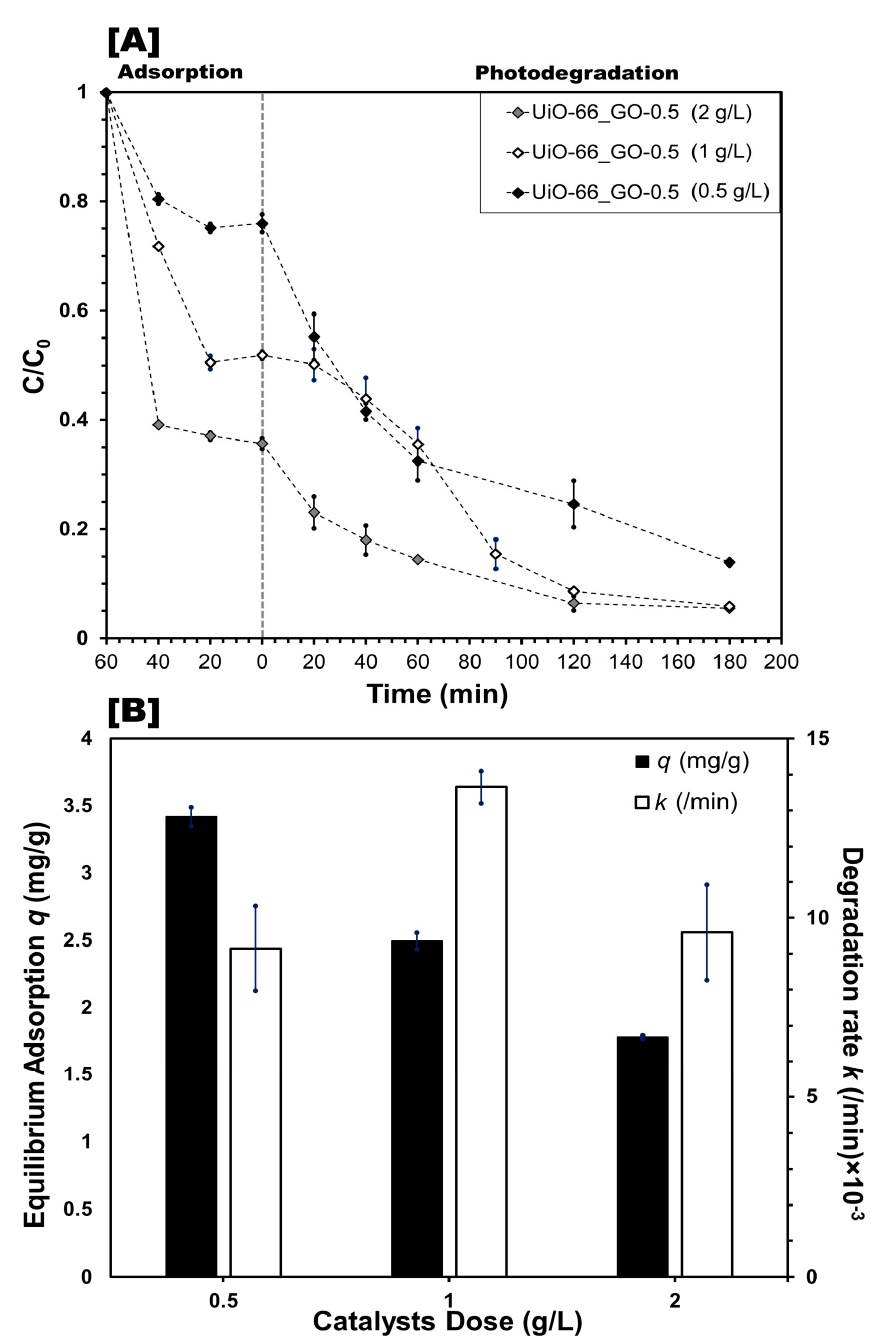
Figure 4. ( A ) Adsorption and photodegradation and ( B ) equilibrium adsorption and photocatalytic rate k of different photocatalyst doses (experimental conditions: initial CBZ concentration = 5 mg/L; pH = 7±0.2; concentration of UiO-66_G-0.5 = 0.5, 1, or 2 g/L; solution volume V = 50 mL). Plots and error bars represent averages and standard deviations from triplicate experiments.